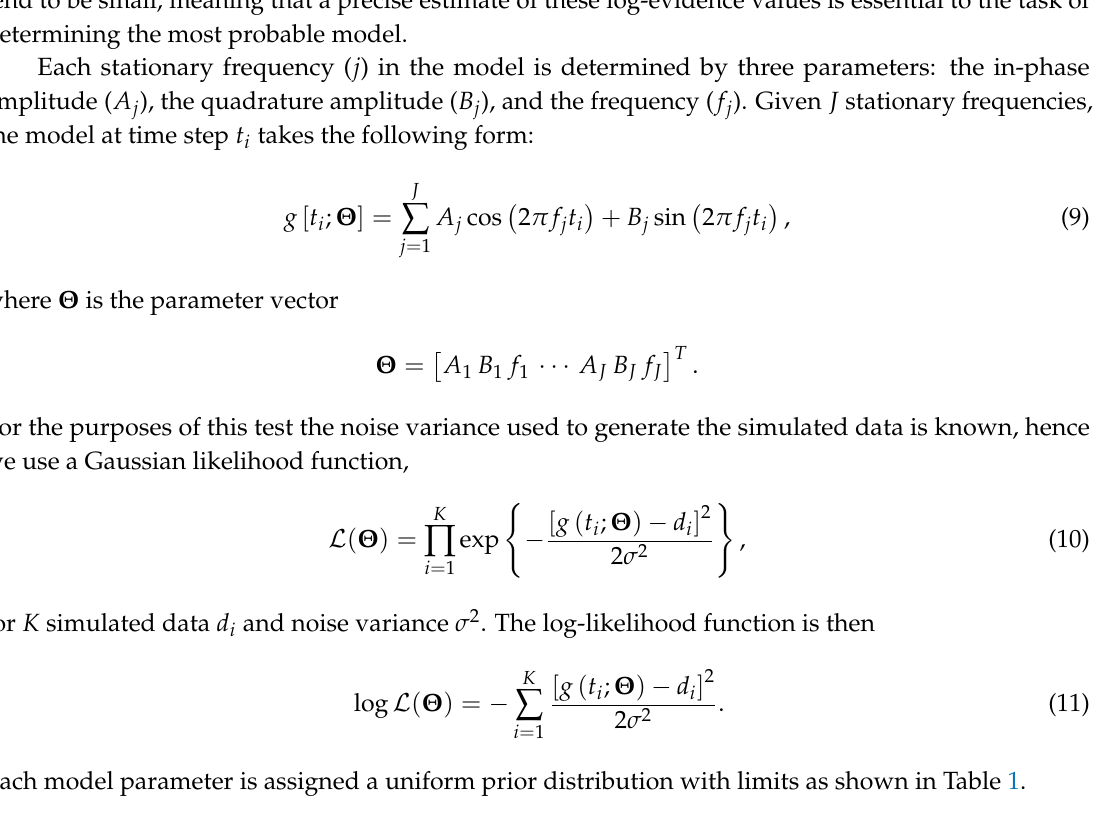
Table 1. Prior bounds for multiple stationary frequency model